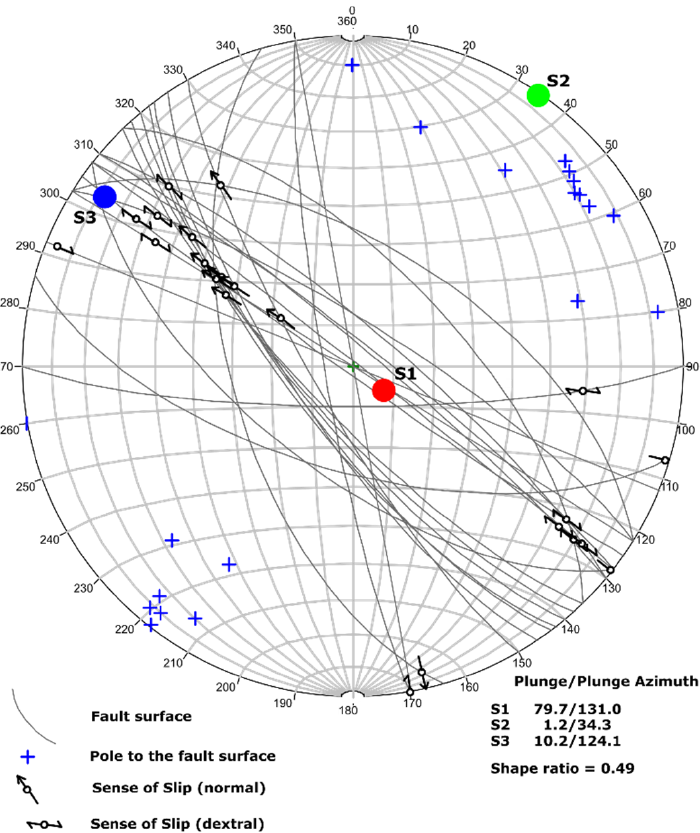
Figure 5. Results of the stress inversion. S1, S2, S3—principal stresses (S1 > S2 > S3).